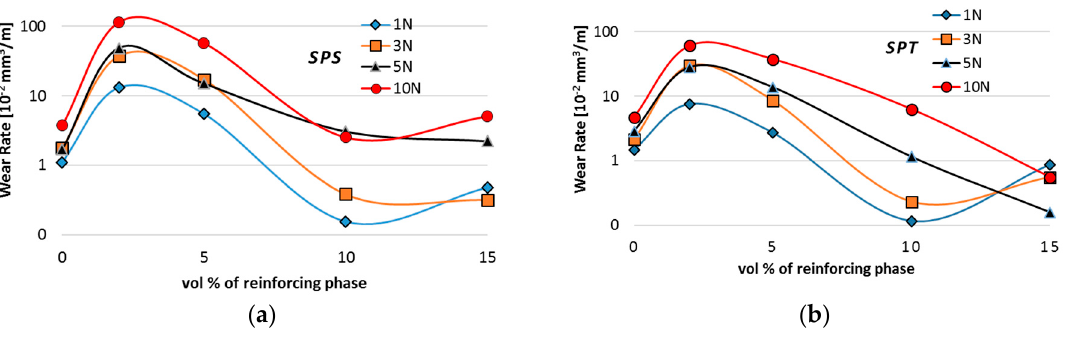
Figure 16. Wear rate of AA6061/MLG composites obtain in SPS ( a ) and SPT ( b ) process.